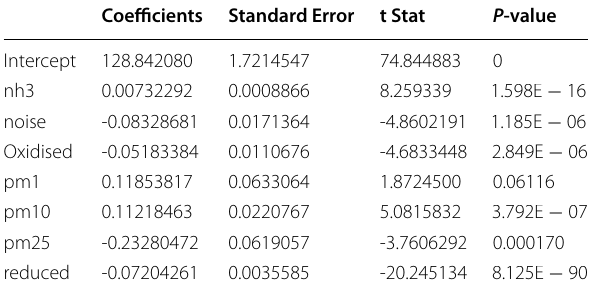
Table 4 Multiple Regression Analysis between HR and Environmental variables